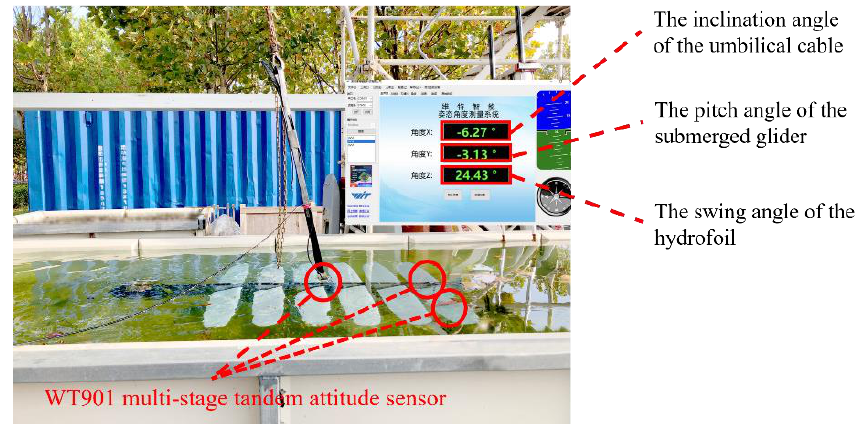
Figure 20. The large-scale wave simulation experiment platform.